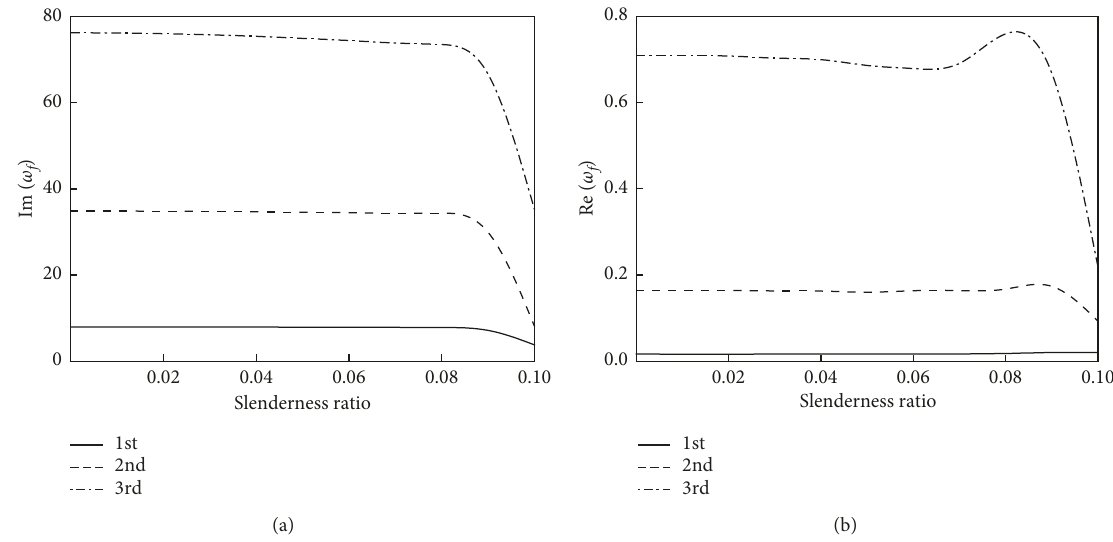
Figure 4: Variation curves of complex frequency of the system with slenderness ratio at r